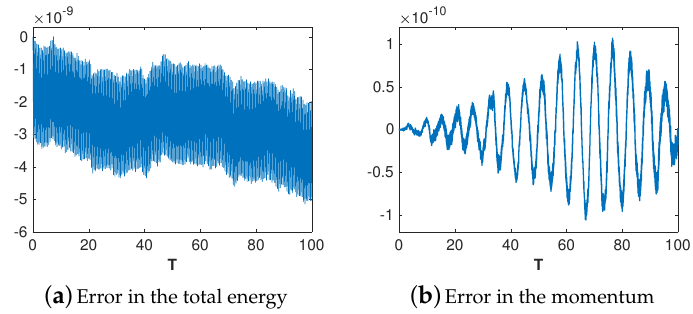
Figure 4. Time history of the error in the total energy and linear momentum with P 2 basis and h = 0.1. (left) error in the total energy; (right) error in the linear